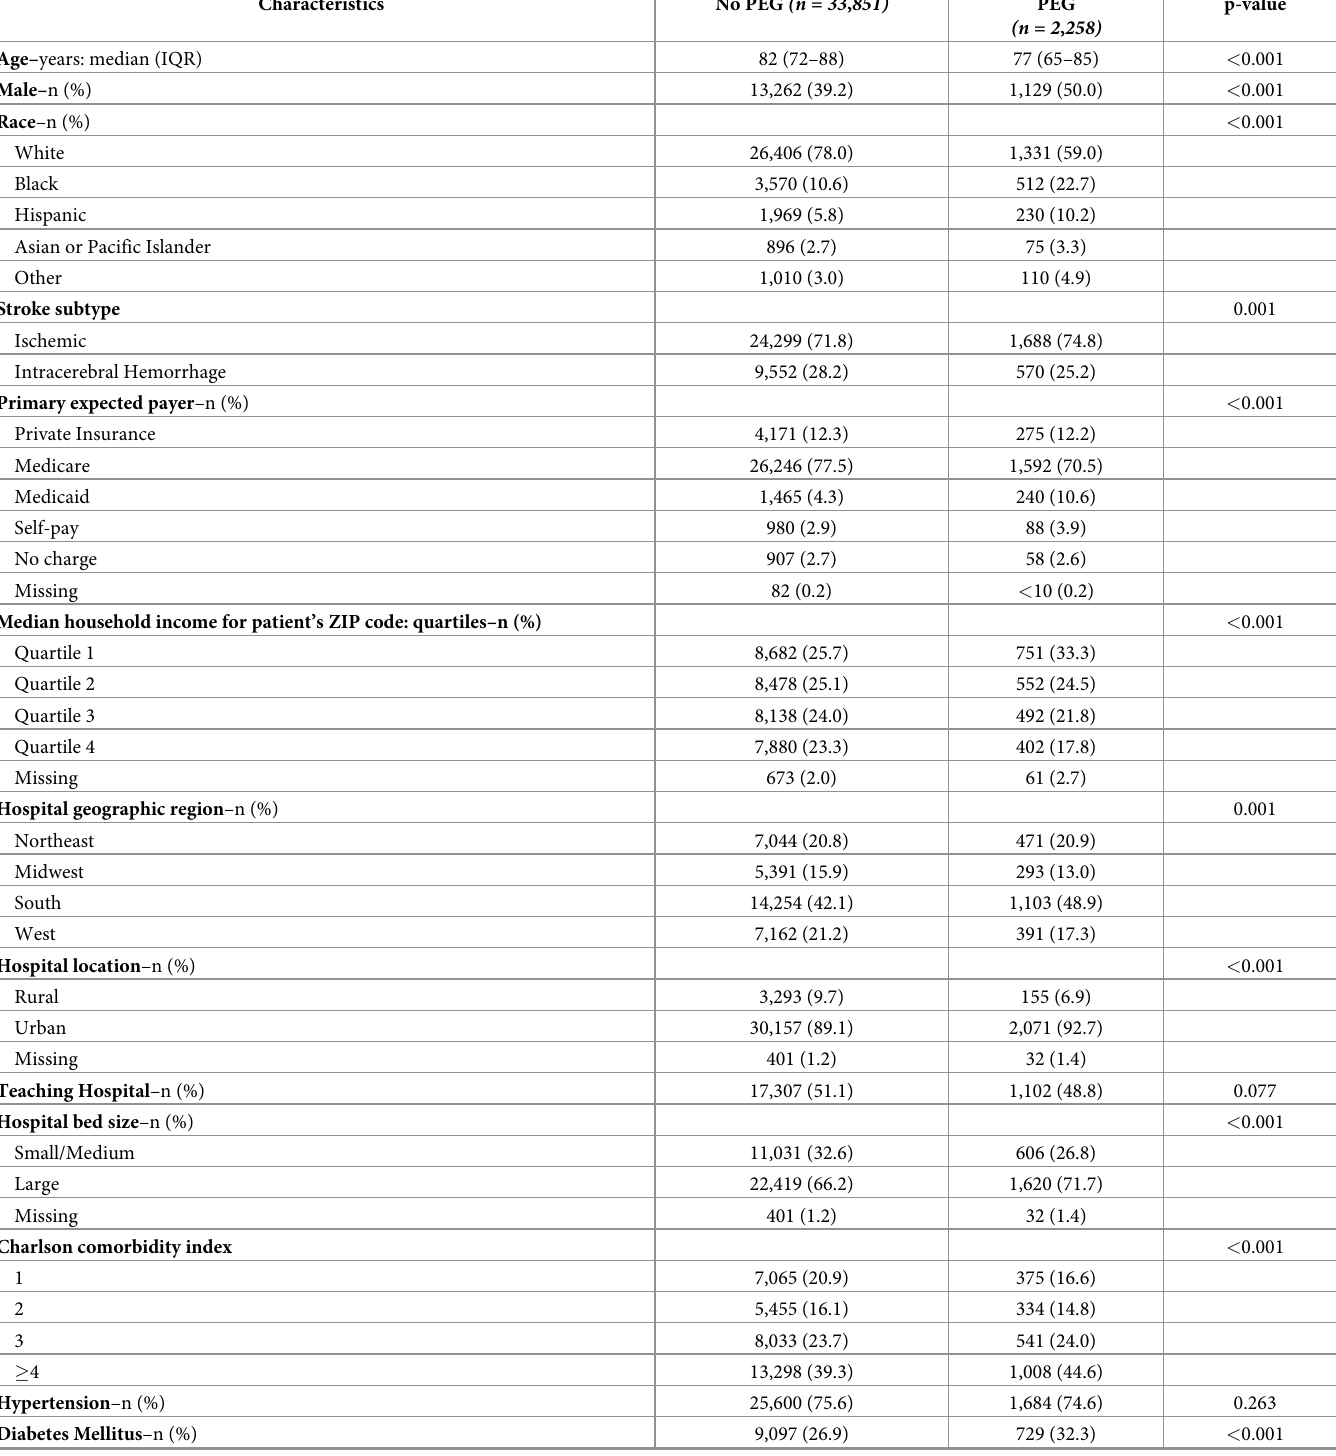
Table 1. Baseline characteristics of the study population comprised of stroke admissions with eventual palliative/withdrawal of care, discharge to hospice, or in- hospital death, stratified by PEG status (n = 36,109). APR-DRG: all patient refined diagnosis-related group; PEG: percutaneous endoscopic gastrostomy. P-values com- pare patients with and without